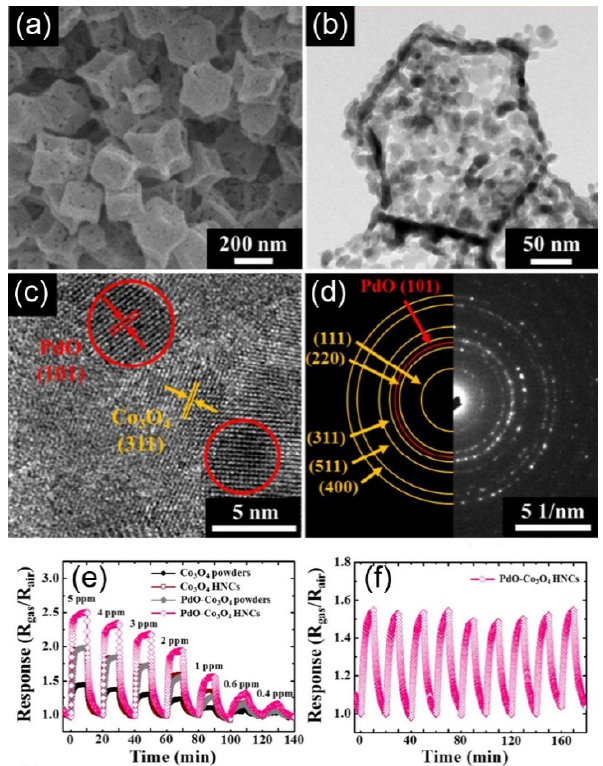
Figure 6. SEM image ( a ), TEM image ( b ), HRTEM ( c ) and SEAD patterns ( d ) of the Co 3 O 4 hollow nanocages (HNCs) decorated with PdO nanoparticles (p-p junctions), the dynamic sensing behaviours of the sensors based on Co 3 O 4 powders, pure Co 3 O 4 hollow nanocages, PdO-Co 3 O 4 powders and PdO-Co 3 O 4 HNCs towards 0.4–5 ppm acetone at 350 °C ( e ), the stability of the sensing performance of PdO-Co 3 O 4 HNCs towards 1 ppm acetone ( f ). Copied with permission [101]. Copyright 2017, American Chemical Society.